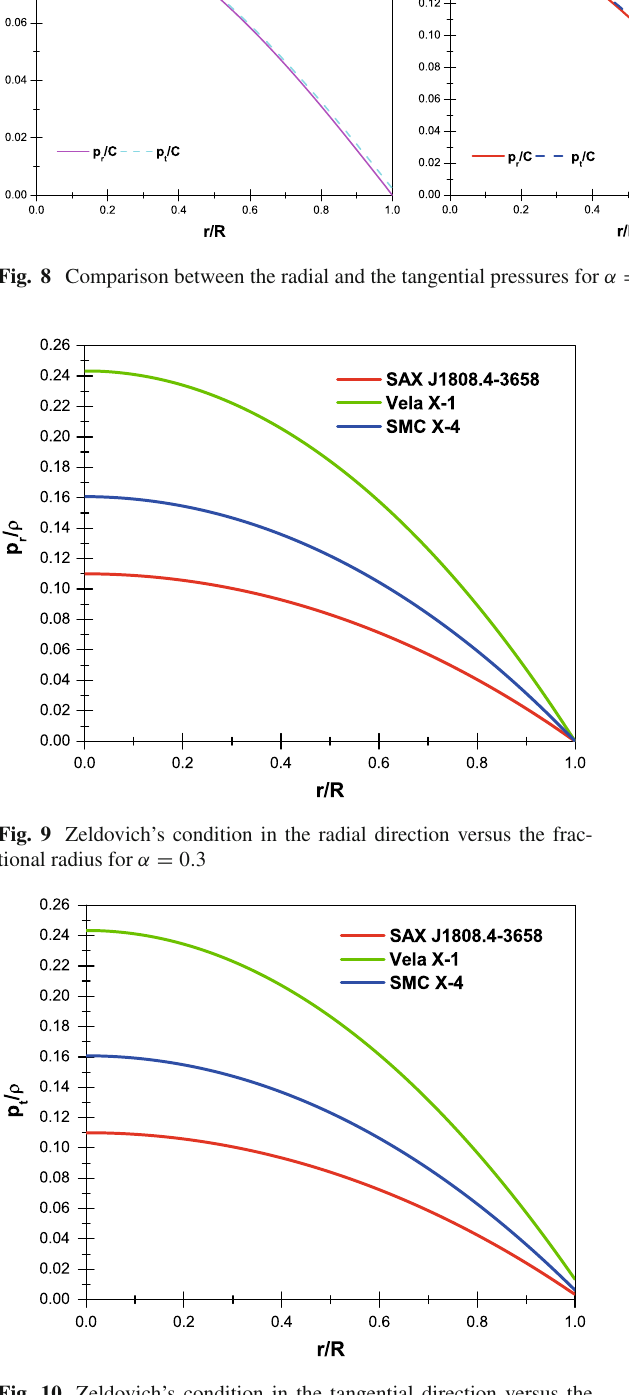
Fig. 10 Zeldovich’s condition in the tangential direction versus the fractional radius for α = 0 .